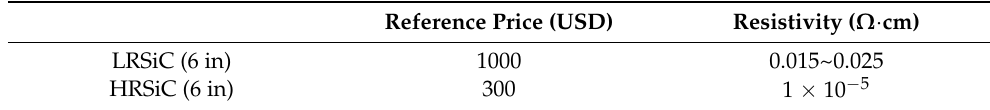
Table 4. Comparison of LRSiC and High-Resistivity SiC (HRSiC) Substrates. Reproduced with permission from ref. [148]. Copyright 2021 MDPI.